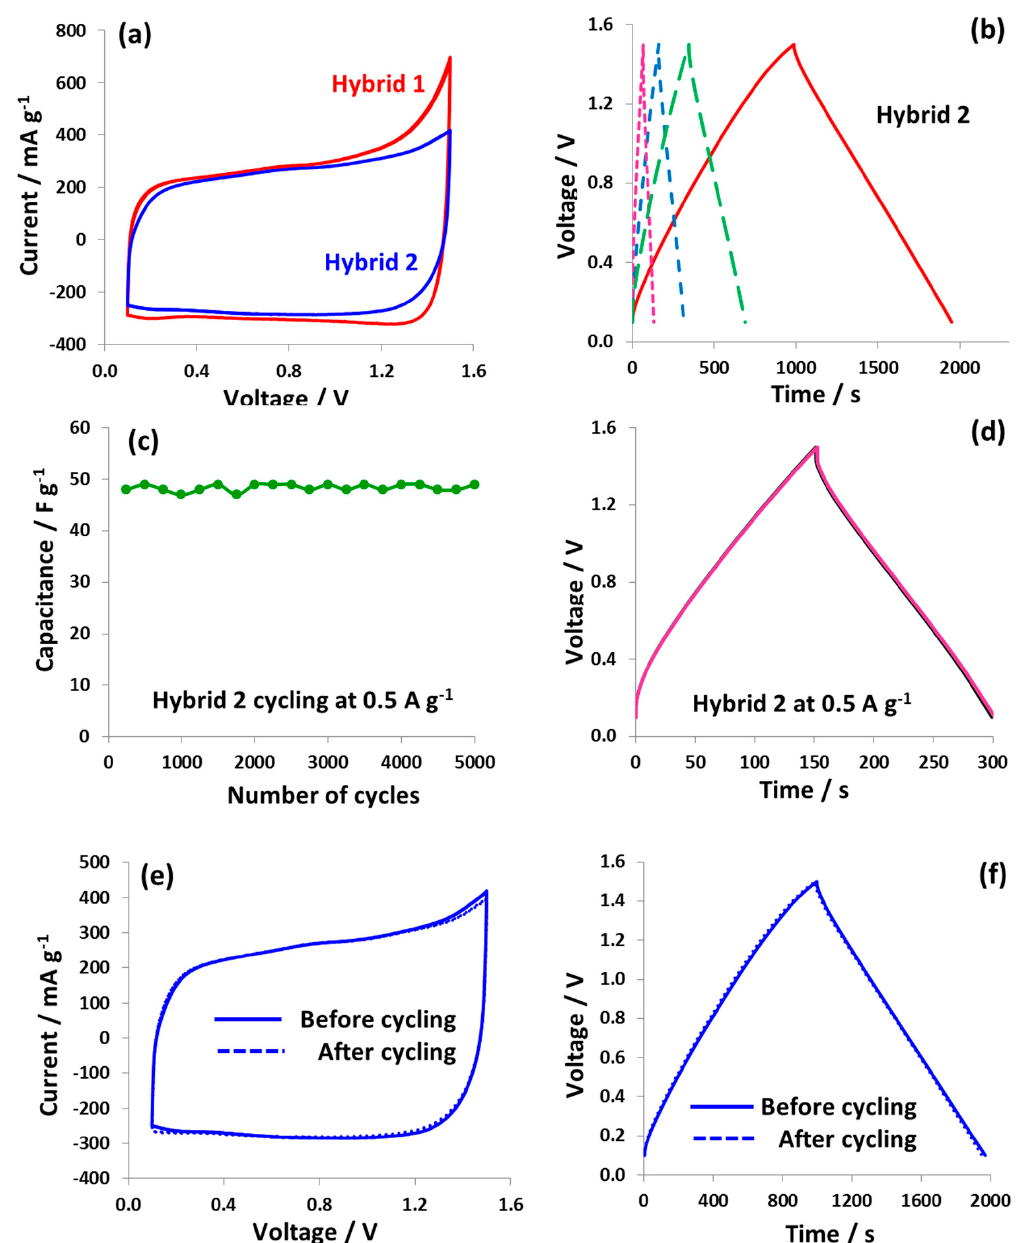
Figure 6. ( a ) Two-electrode cell cyclic voltammograms of hybrid cell 1 and hybrid cell 2; ( b ) galvanostaitic charge/discharge curves of hybrid cell 2 in 1 mol L − 1 NaNO 3 at various specific currents of 0.1 A g − 1 (full line), 0.25 A g − 1 (big dashed line), 0.5 A g − 1 (small dashed line), and 1.0 A g − 1 (dotted line); ( c ) capacitance evolution of hybrid cell 2 for each 250 th galvanostatic charge/discharge cycle at 0.5 A g − 1 over a period of 5000 cycles. ( d ) Comparison of curves after each 1000 th galvanostatic charge/discharge cycle; two-electrode cell performance of hybrid cell 2 in 1 mol L − 1 NaNO 3 with ( e ) CVs at 2 mV s − 1 and ( f ) galvanostatic charge/discharge at 0.1 A g − 1 up to 1.5 V before (full line) and after (dashed line) galvanostatic cycling.